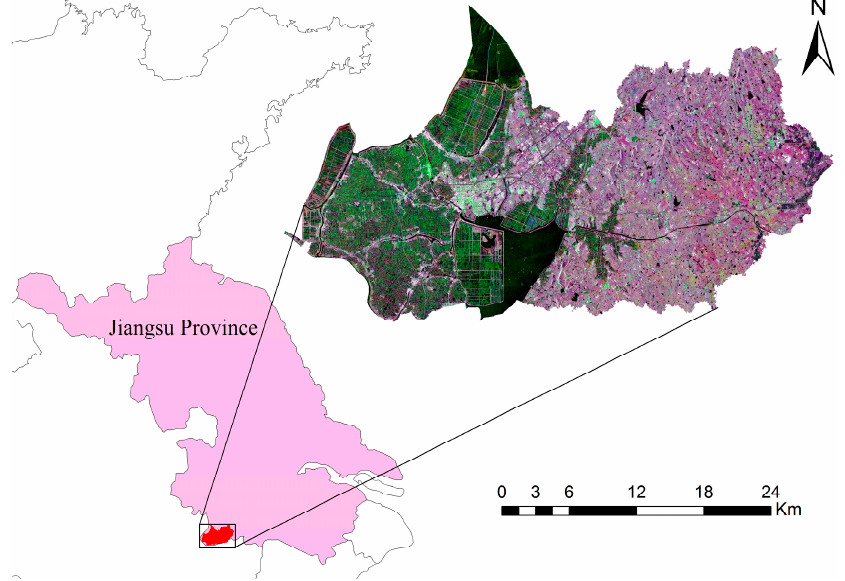
Figure 1. The study area is located in the southwest of Jiangsu Province, China and an overview of the SAR data (R: 12 November 2015 VH polarization, G: 21 March 2016 VV polarization, B: 8 May 2016 the SAR data (R: 2015-11-12 VH polarization, G: 2016-03-21 VV polarization, B: 2016-05-08 VH VH polarization).